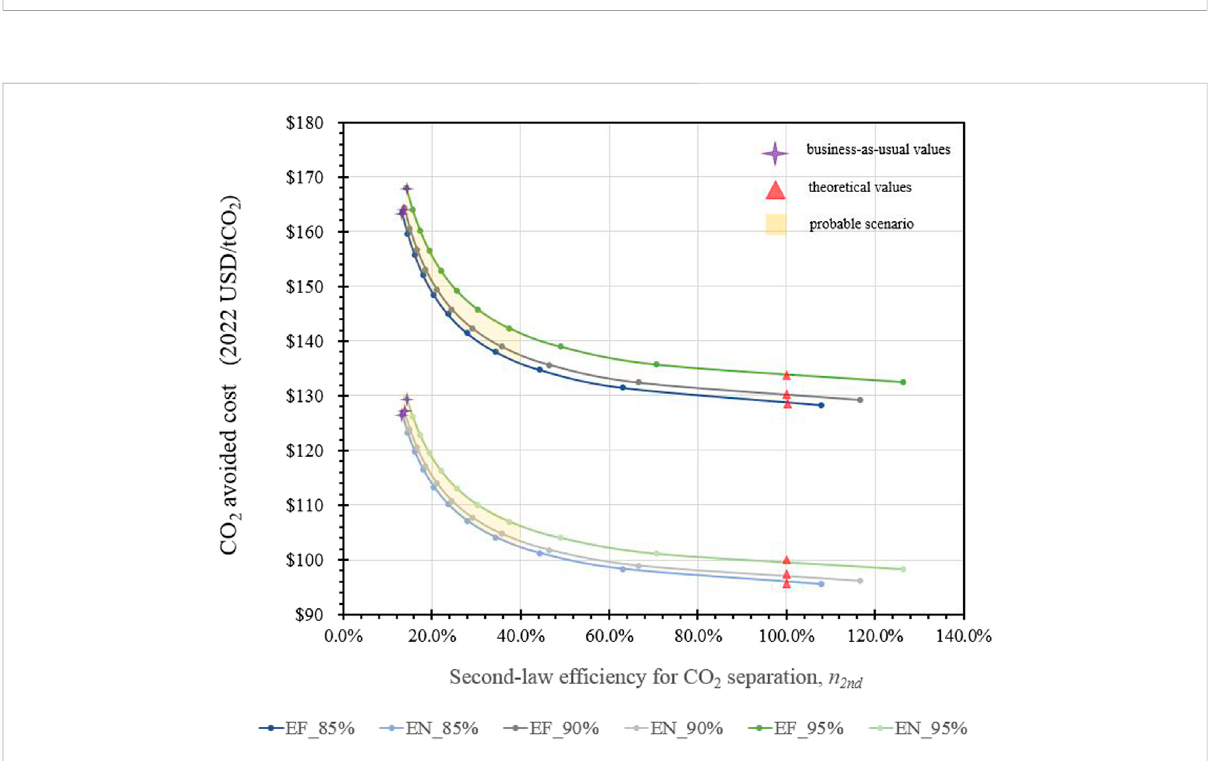
FIGURE 7 Effect of the W regen on the η 2 nd and CAC for EGR power plant with PCC by type of plant (FOAK and NOAK) at different capture levels.